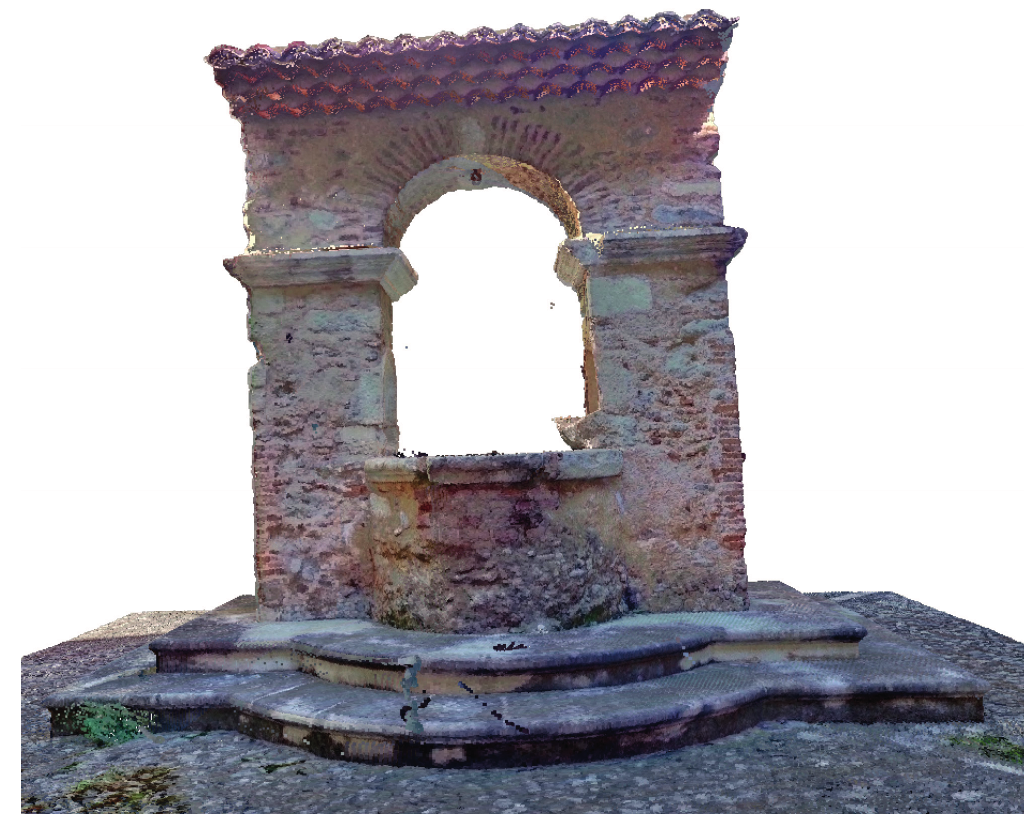
Figure 4. Tridimensional mesh of the well inside the cloister of the